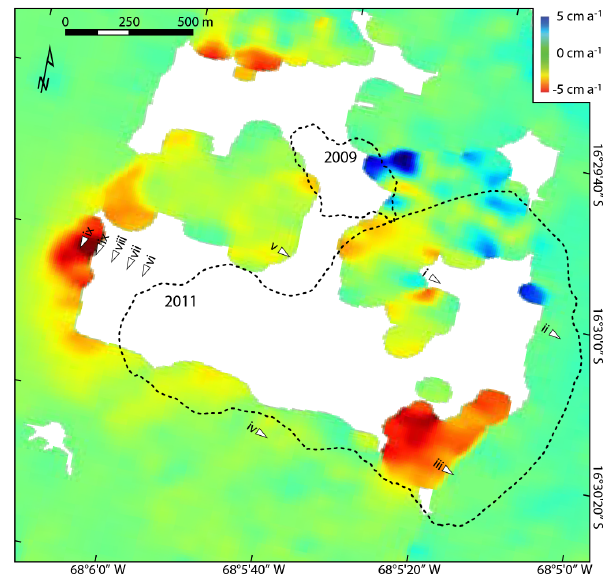
Figure 10. Change in line-of-sight slope creep of the Pampahasi area following the 2011 failure relative to pre-failure creep. Positive and negative values indicate, respectively, decreased and increased post-failure displacement rates away from the satellite. Green ar- eas experienced no change in displacement and were largely stable both before and after the 2011 landslide. White areas lacked coher- ence phase in pre-failure scenes, post-failure scenes, or both. Ro- man numerals show locations of displacement histories in Fig.